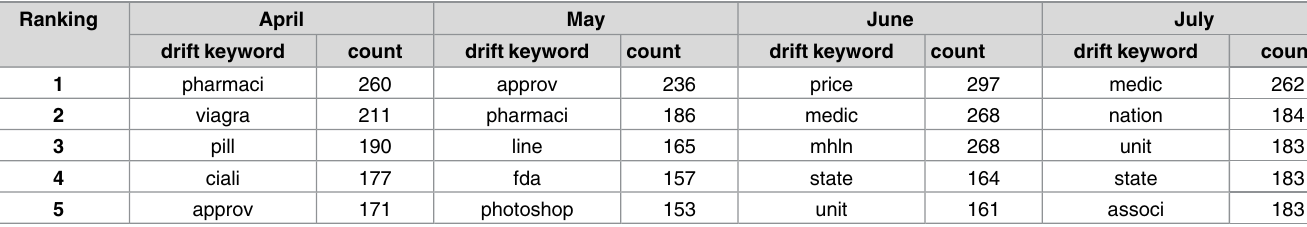
score of concept drift (recorded in the Critical Attribute “Concept drift”) to help the decision tree algorithm to detect the suspicious titles frequently appear in recent days. Therefore, the values of F-measure in Experiment C are higher than those of the other experiments. Table 5 shows the Precision, Recall and F-measure of various months by the spam filtering method proposed in this study. With the incremental learning mechanism, our filtering meth- od’s ability of adapting to the dynamic environment has been strengthening. Obviously, the values of Precision, Recall and F-measure are increasing month after month. Our filtering method in July has Recall as high as 0.995, Precision at 0.960, and F-measure at 0.977. The average values of Precision, Recall, and F-measure of each month are 0.955, 0.970, and 0.9594 respectively. Note that we check only the header of email to improve executive efficiency and diminish the computation complexity. Therefore, our method is different from those filtering methods at present that have to analyze fully the email’s content. Table 6 shows the top 5 keyword counts computed by the Sliding Window of each month. These keywords are extracted from the spam emails’ title. As seen, these spam keywords repeatedly appears during one month. And the keywords recorded by the Sliding Window during various months are not necessarily the same. The spammers always send out a large number of advertising spams with the similar titles, therefore, such type of emails can be detected easily by the mechanism of the weighted Sliding Window proposed in this paper. Relatively higher score of concept drift (i.e., the value of Critical Attribute “Concept drift”) will be judged for such type of emails to help our filtering system to correctly detect this type of spams. Table 7 shows the comparison of the method proposed in this paper and other methods. The four month average F-measure in this study is 0.962, which is better than that of each of other methods. The Precision values of some methods are higher than the 0.955 of our method, repre- senting that those methods have higher spam classification accuracy than this study. However, their Recall values are all lower than the 0.97 of this study and our method has the best value of F-measure, indicating that the overall judgment accuracy rate of our filtering system in this study is relatively higher. Moreover, our method checks only email’s header section, and this technique will improve executive efficiency and diminish computation complexity.